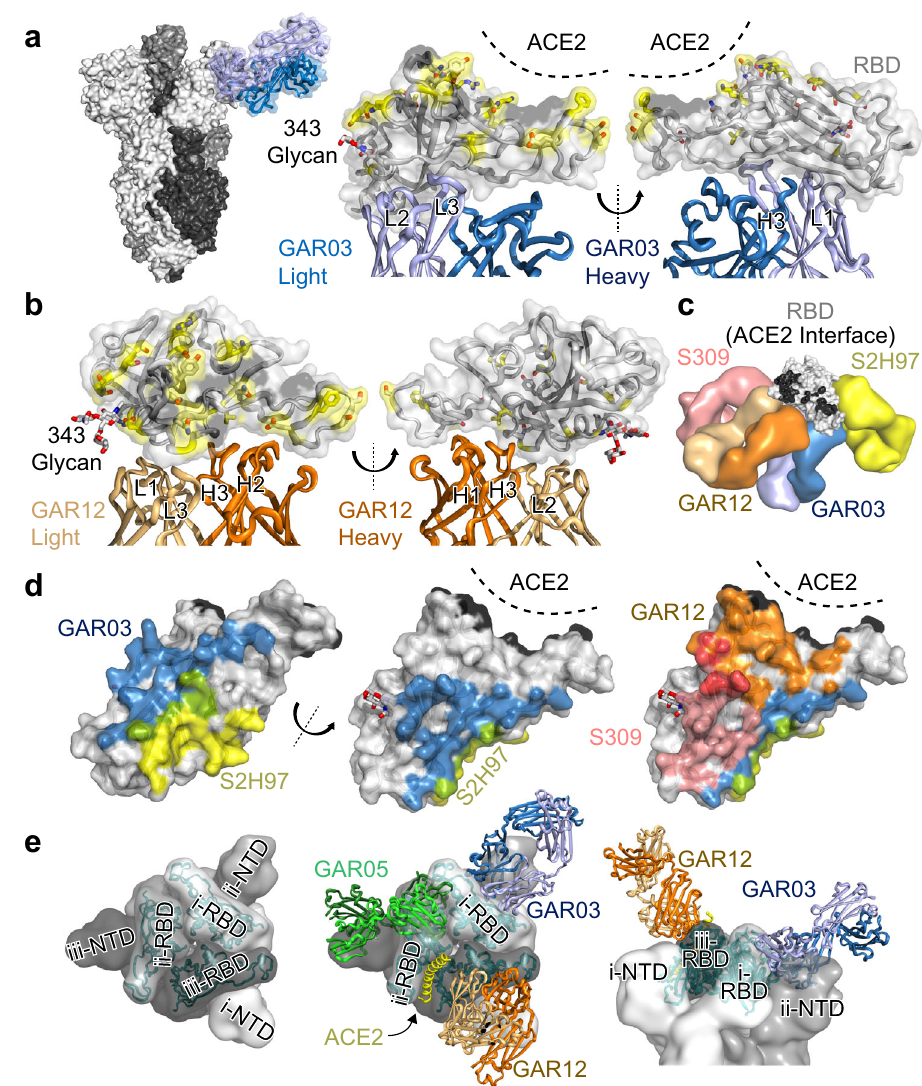
Fig.3|Structuralidenti fi cationofanovelclass6epitope.a Cryo-EMstructureof spike trimer (three shades of grey surface) complexed with GAR03 (blue cartoon and transparent surface) revealing a single GAR03 antibody Fab bound to trimeric spike (resolution 3.39Å). Binding displaces the S1 domain (N-terminal domain and RBD)ofoneoftheprotomers(disorderedandnotvisibleinthecryo-EMmap),with the GAR03 Fab binding to the RBD of the adjacent protomer. Middle and right panels show two perspectives of the RBD-GAR03 crystal structure. The binding interface is dominated by the GAR03 light chain (light blue cartoon; CDRs L1, L2, and L3) with more minor contribution from the heavy chain (dark blue; CDR H3). The ACE2 interface of the RBD (grey surface and cartoon) is shaded black, whilst Omicron VOC mutation positions are indicated by yellow sticks and surface, and N343 linked carbohydrate is shown as sticks. b Crystal structure of GAR12 (heavy and light chains colored darkand light orange)incomplex with RBD(greycartoon andsurface,withACE2interfacecoloredblack,andOmicronVOCscoloredyellow).